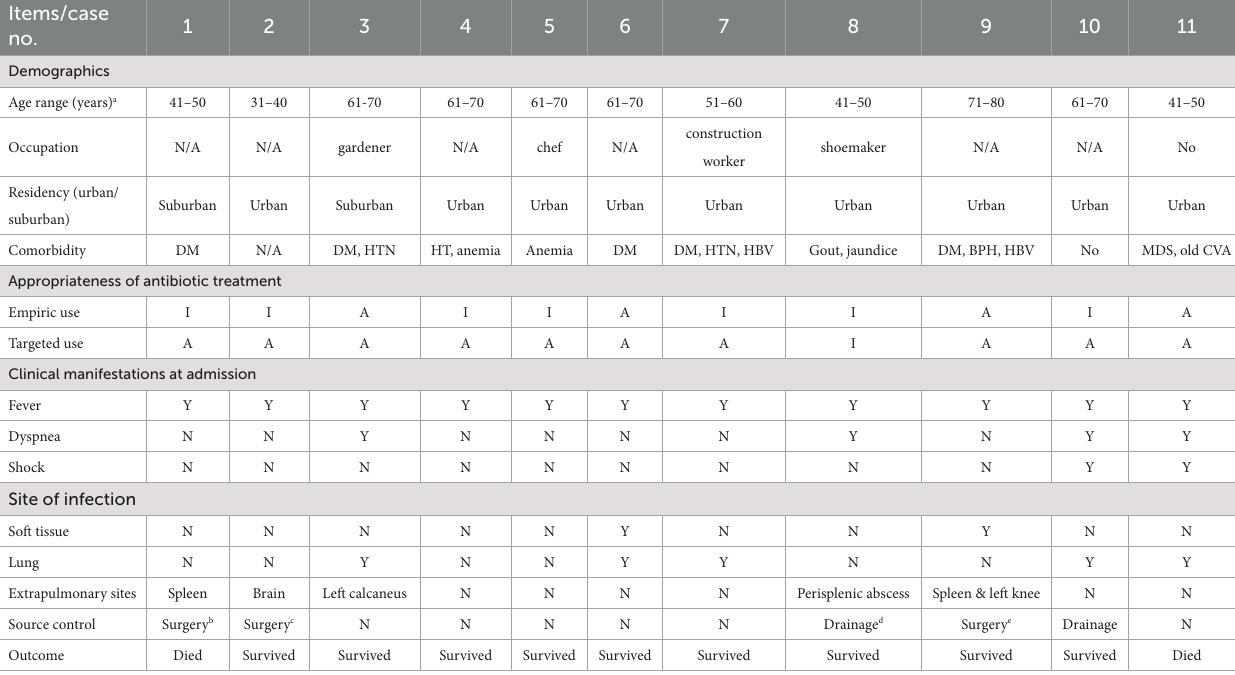
Survived Survived Survived Survived Survived Survived Died